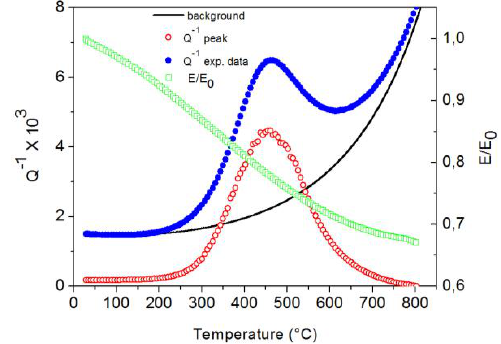
Figure 2. Q −1 and E , normalized to the room temperature value E 0 , are reported vs. temperature. The Q −1 curve (full blue circles) is the superposition of a broad peak (open red circles) and an exponentially increasing background (black line). Resonance frequency f = 750 Hz.